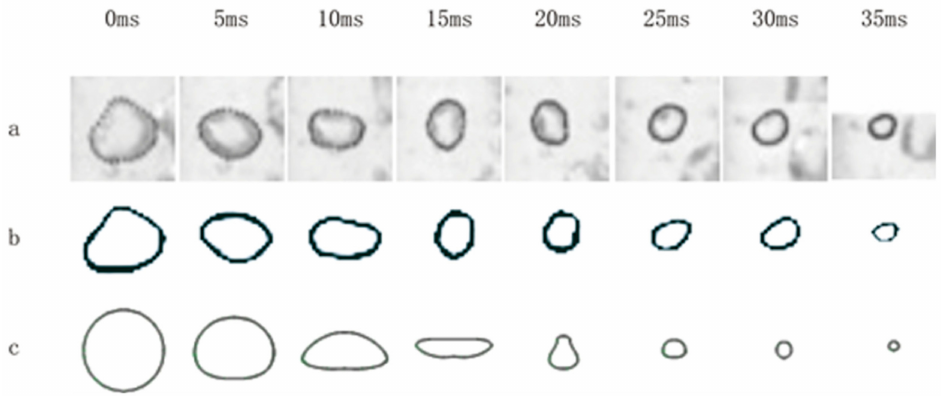
Figure 7. Comparison of bubble contour changes.